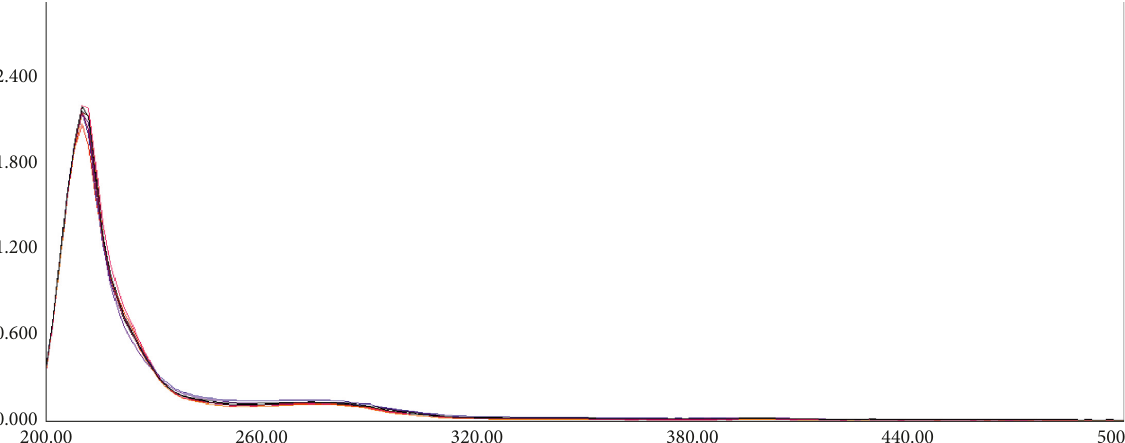
Figure 5: The spectrum of blank plasma from randomized rat in multidose ( n